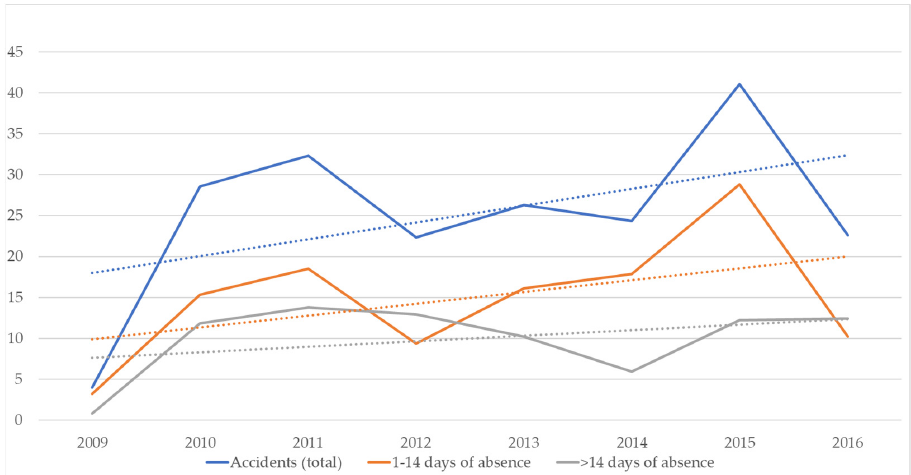
Figure 5. Incidence rates in construction of roads and motorways. Based on data from [17 – 24,27] .